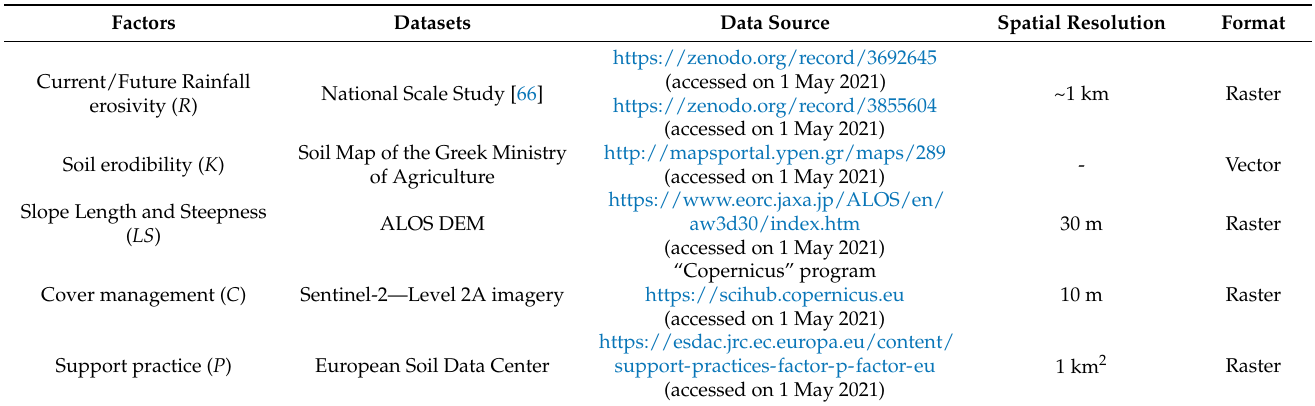
Table 1. Summary of the input datasets and sources used for the estimation of soil loss in RUSLE